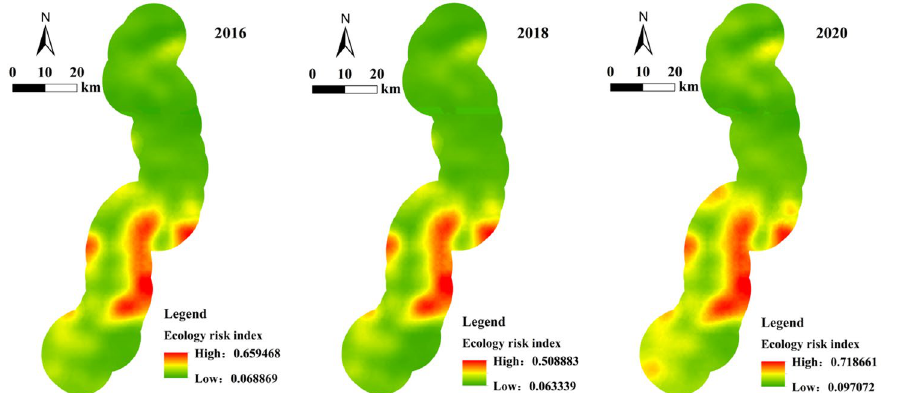
Figure 5. The distribution of ecological risk index along the highway in 2016, 2018, and 2020.